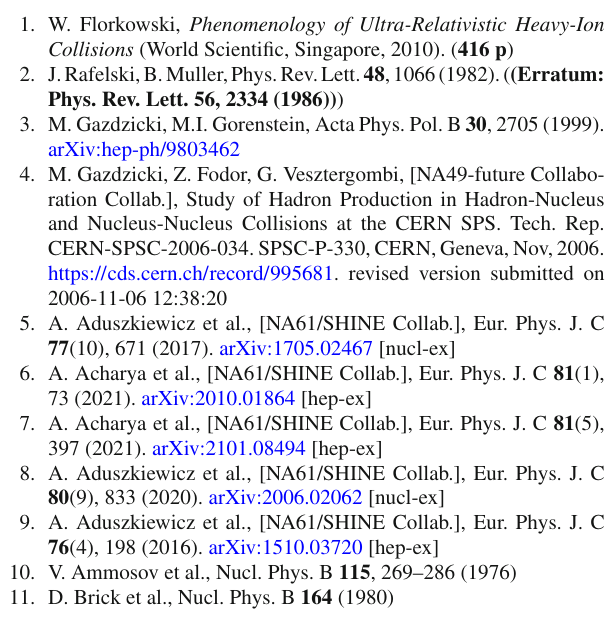
Fig. 13 Collision energy dependence of mean multiplicity of K 0 mesons produced in p+p interactions. The solid coloured red circle shows the measurement by NA61/SHINE presented with its systematic uncertainty. The results published by other experiments are shown by open diamonds coloured in blue (CERN), open stars coloured in green (FNAL), open triangle pointing up coloured in orange (BNL), open tri- angle pointing down coloured in magenta (SERPUKHOV) and open square coloured in black (SLAC). All the data points are shown with combined statistical and systematic uncertainties. The references for the plotted data points are given in the